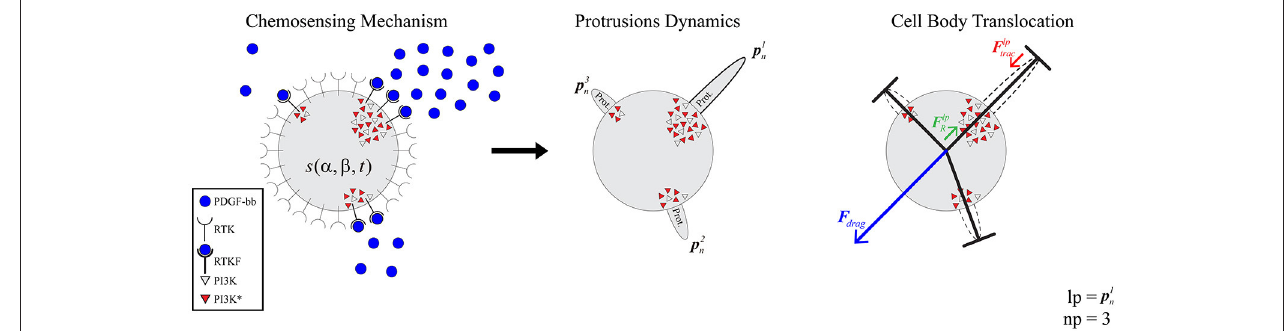
FIGURE 1 | Global model scheme. (Left) the chemosensing mechanism simulates how RTKs located in the cell membrane become activated by binding to PDGF-BB molecules (blue circles). This RTK activation, in turn, triggers the activation of PI3K molecules inside the cell (PI3K inactivated molecules as gray triangles and PI3K activated ones as red triangles). (Middle) protrusions ( p i n ) grow and stabilize on those areas with high concentration of PI3K activated molecules. (Right) the longest protrusion generates a traction force ( F lp trac ) when retracting, which exerts a reaction force ( F lp R ) over the cell body. As a result of these reaction forces, the ECM generates a drag force ( F drag ) over the cell